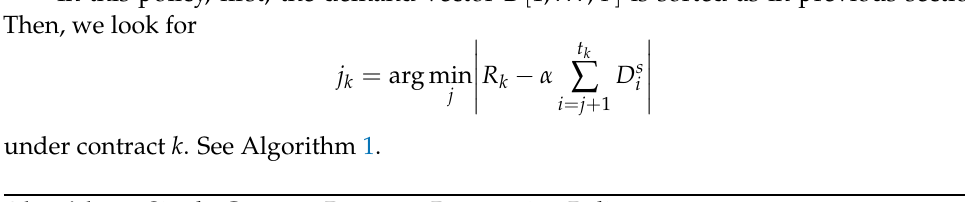
Algorithm 1 Single-Contract Resource Reservation